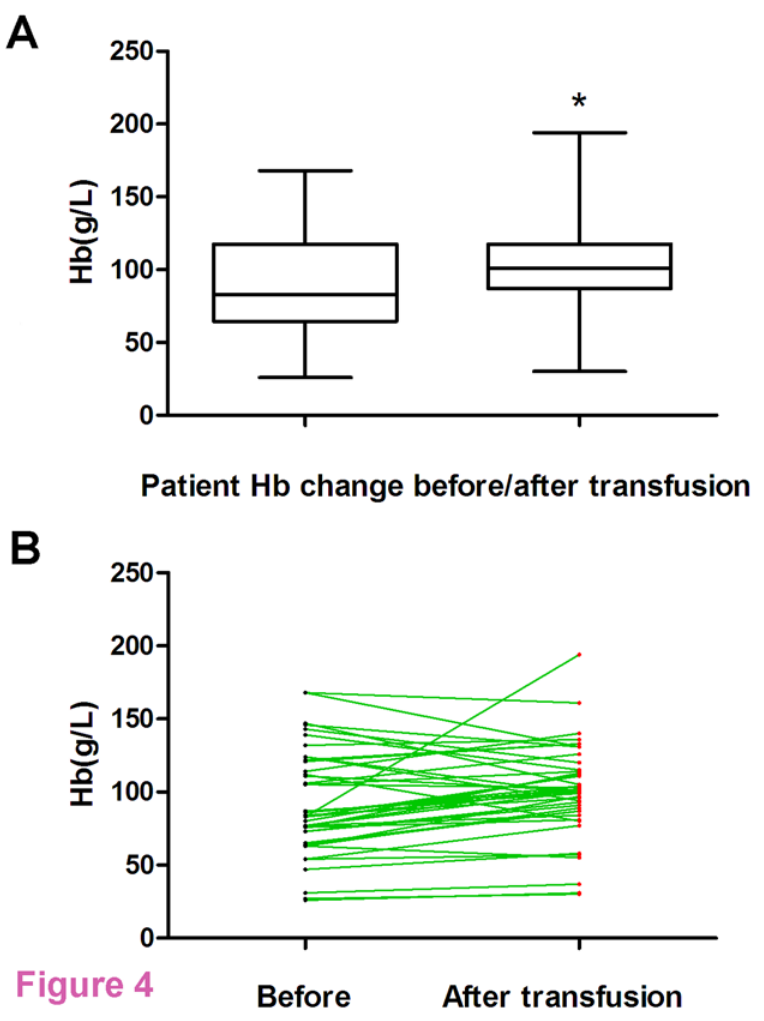
Fig 4. Change in Hb levels of patients before/after transfusion. A . Average Hb levels of 49 patients before and 24 h after transfusion. B . Diagram of Hb levels of 49 patients before and after transfusion. * : p < 0.0001, compared with the ‘ before transfusion ’